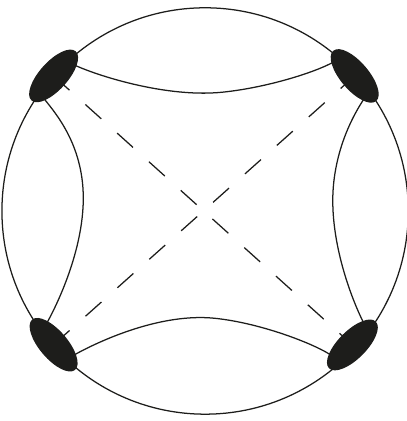
Figure 19 . Witten diagram representation of the f χ correlator, where χ is interpreted as a “triple trace” of the form χ = [ φ 1 φ 2 φ 1 ] . The solid lines denote the φ 1 propagators and the dashed lines denote the φ 2 propagators. The diagram is manifestly s ↔ t crossing